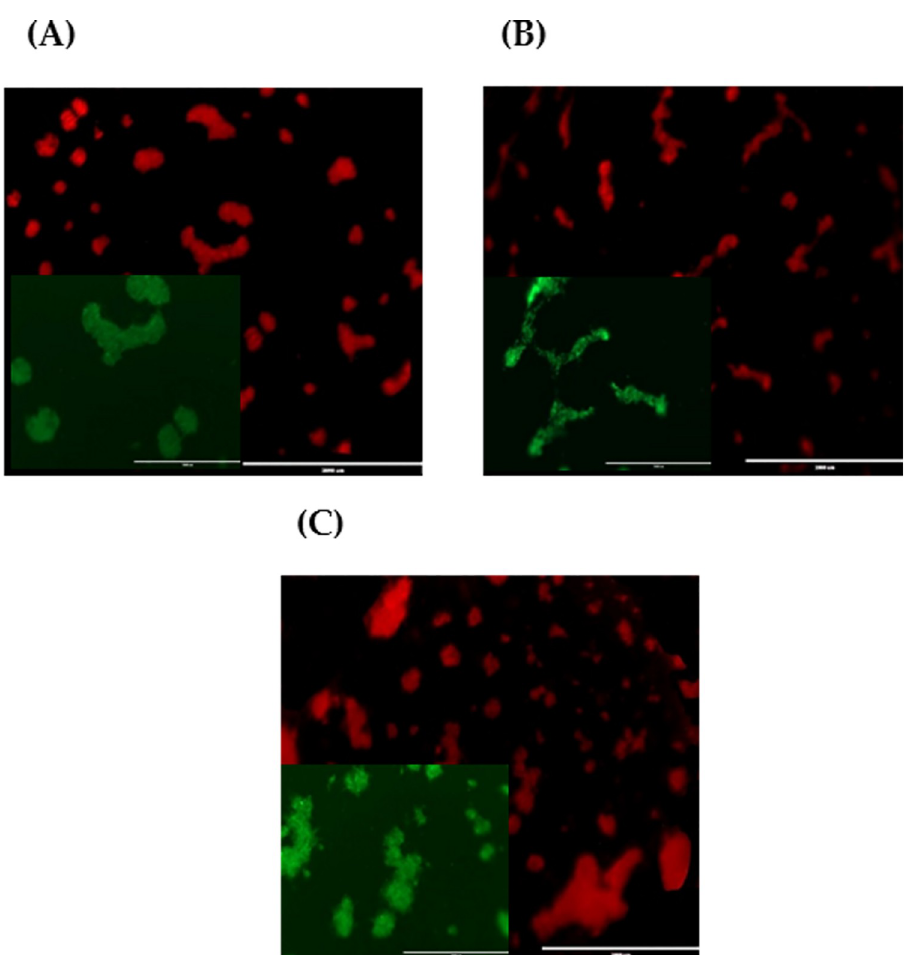
Fig 7. Tube formation of CVMSCs and MDA-MB231 co-culture at different ratios. (A) Co-culture 1 CVMSCs and 1 MDA-MB231; (B) Co-culture 1 CVMSCs and 2 MDA-MB231 and; (C) Co-culture 3 CVMSCs and 1 MDA-MB231 on Matrigel with VEGF for 24h incubation. Images show CD31 (red) and Calcein AM staining (green) staining. 10x magnification for Calcein AM and 2x magnification for CD31.